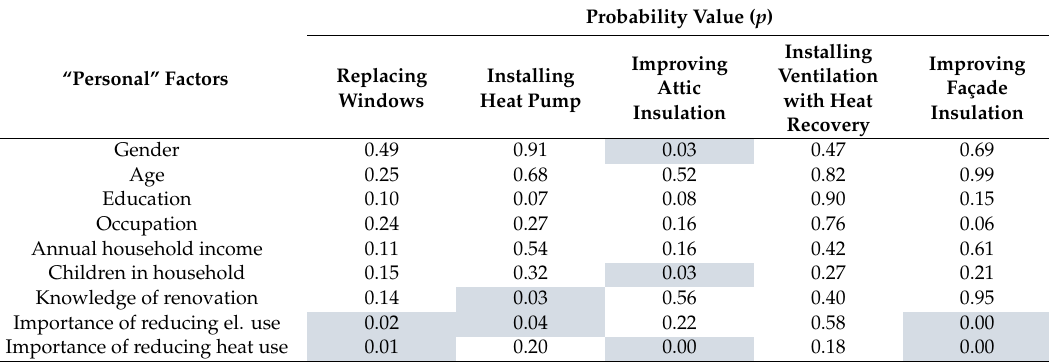
Table 2. Influence of “personal” factors on homeowners’ interest to adopt EEMs.